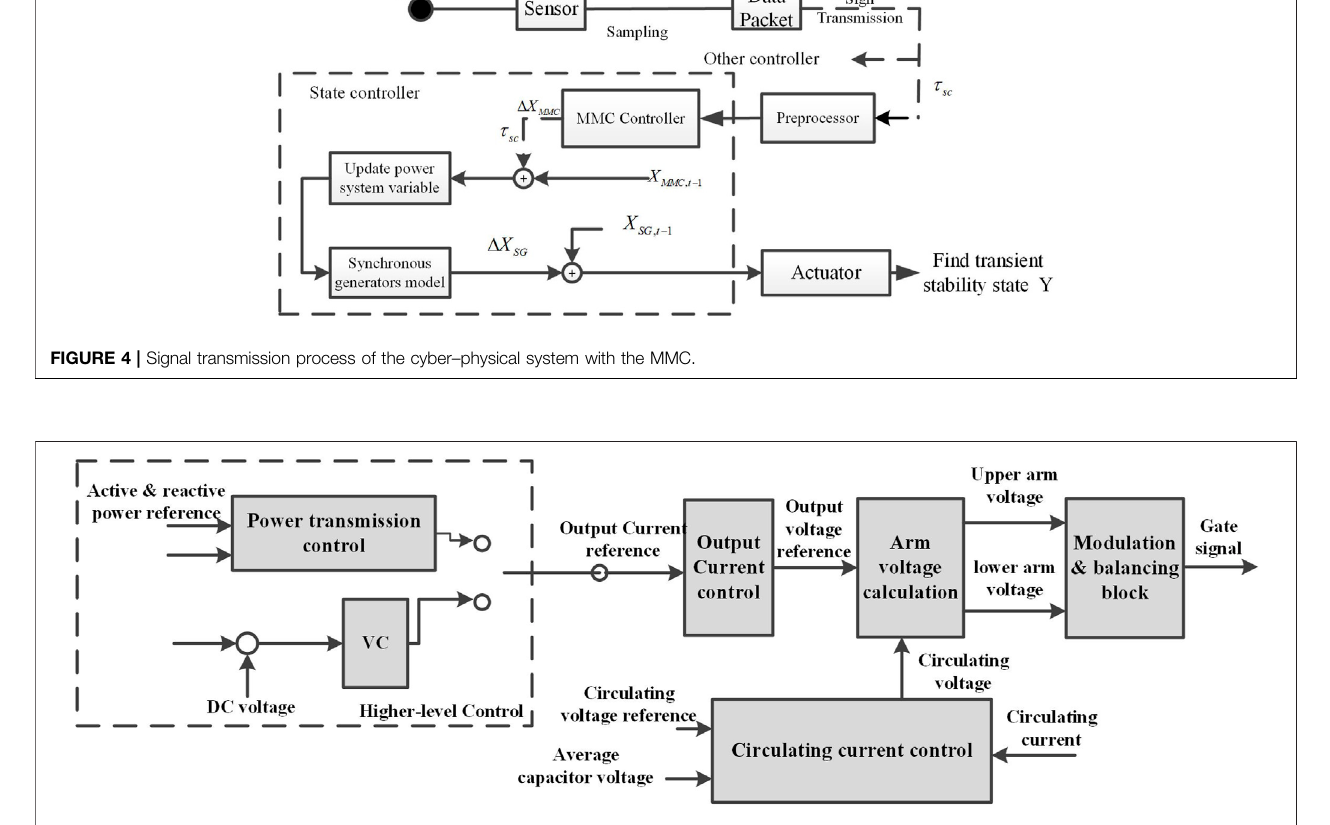
FIGURE 5 | Overview of an MMC cascade control